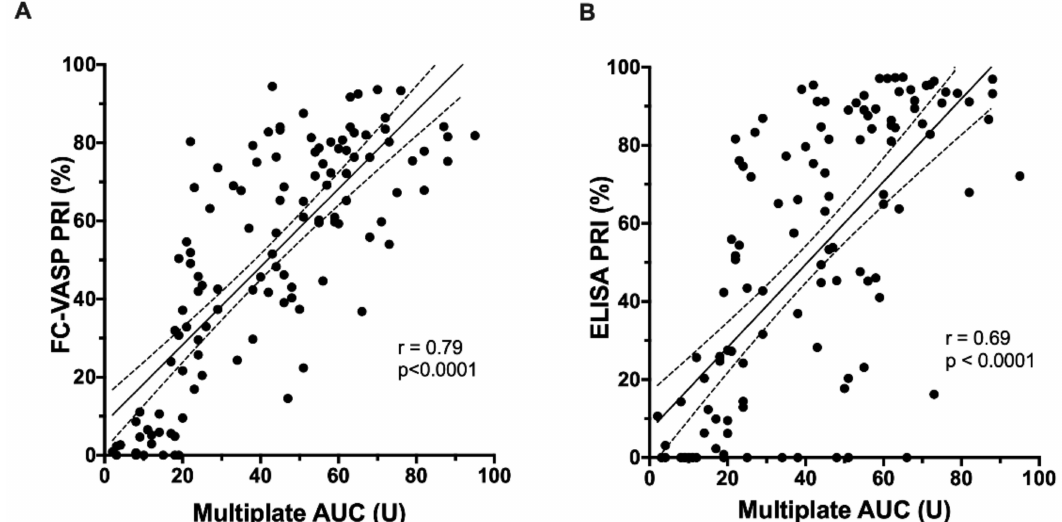
Figure 3. Correlation of VASP phosphorylation assays with the Multiplate ® assay. ( A) Linear regression between flow cytometry-based VASP phosphorylation assessment and Multiplate ® analyzer-based aggregation. ( B ) Linear regression between ELISA-based VASP phosphorylation assessment and Multiplate ® analyzer-based